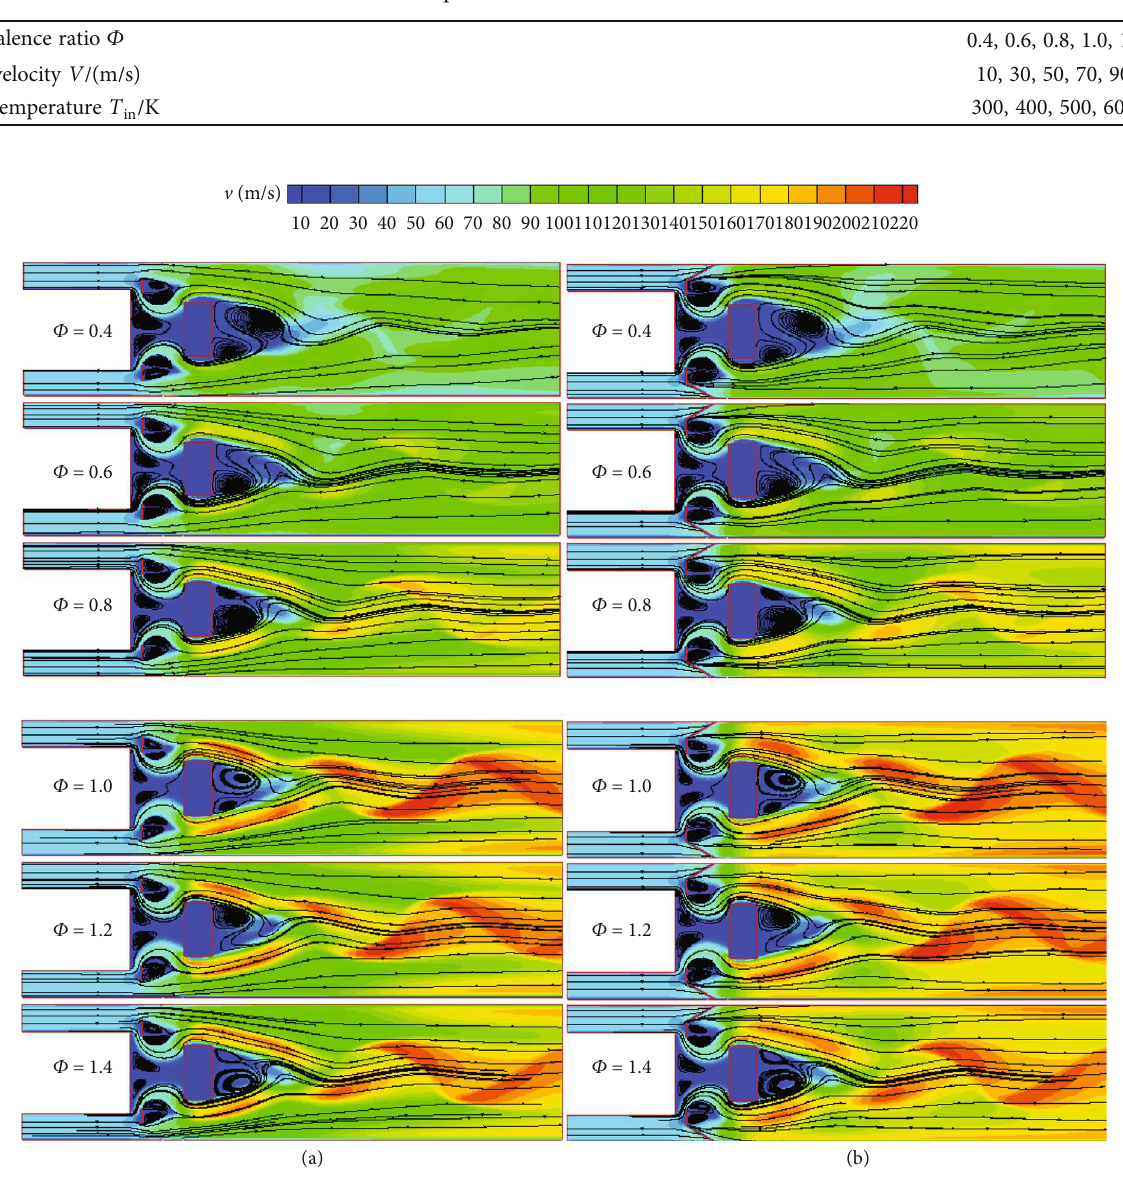
Table 3: Speci fi cation of calculation